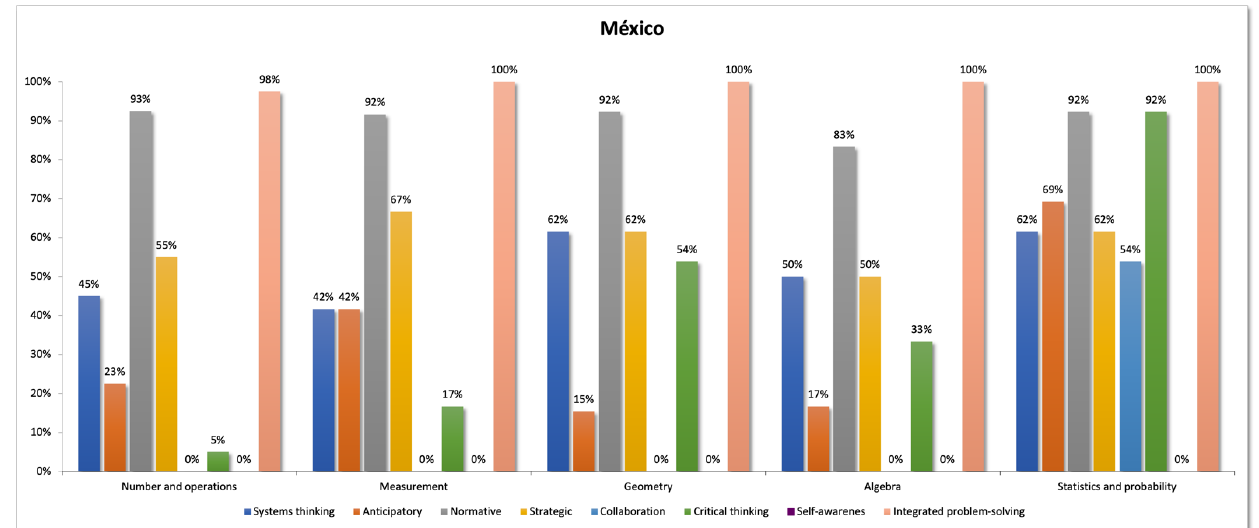
Figure 4. Sustainability competence distribution in Mexico according to thematic axis.